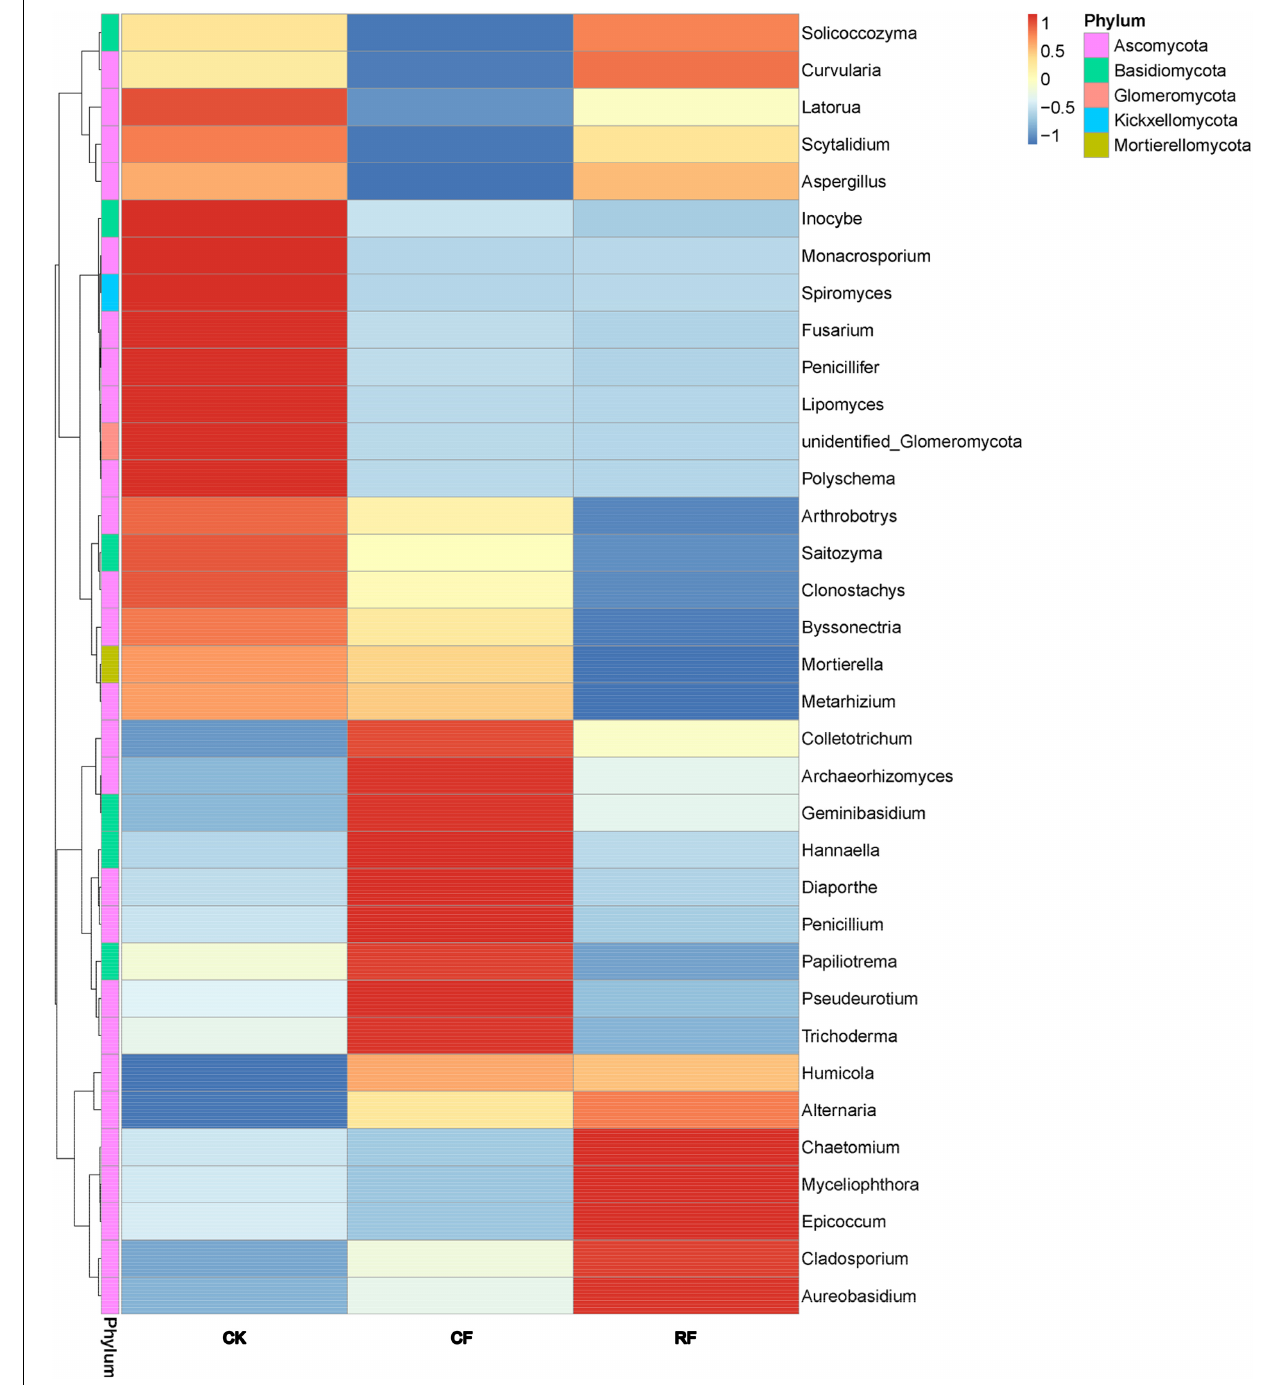
FIGURE 3 | Microbial community heatmap analysis of the fungal genus detected across all of the samples. The relative values for fungal genus are indicated by color intensity with the legend in the upper right of the picture. CK, CF, and RF indicated without fertilizer applied, with compound fertilizer applied, and with reduced fertilizer applied,